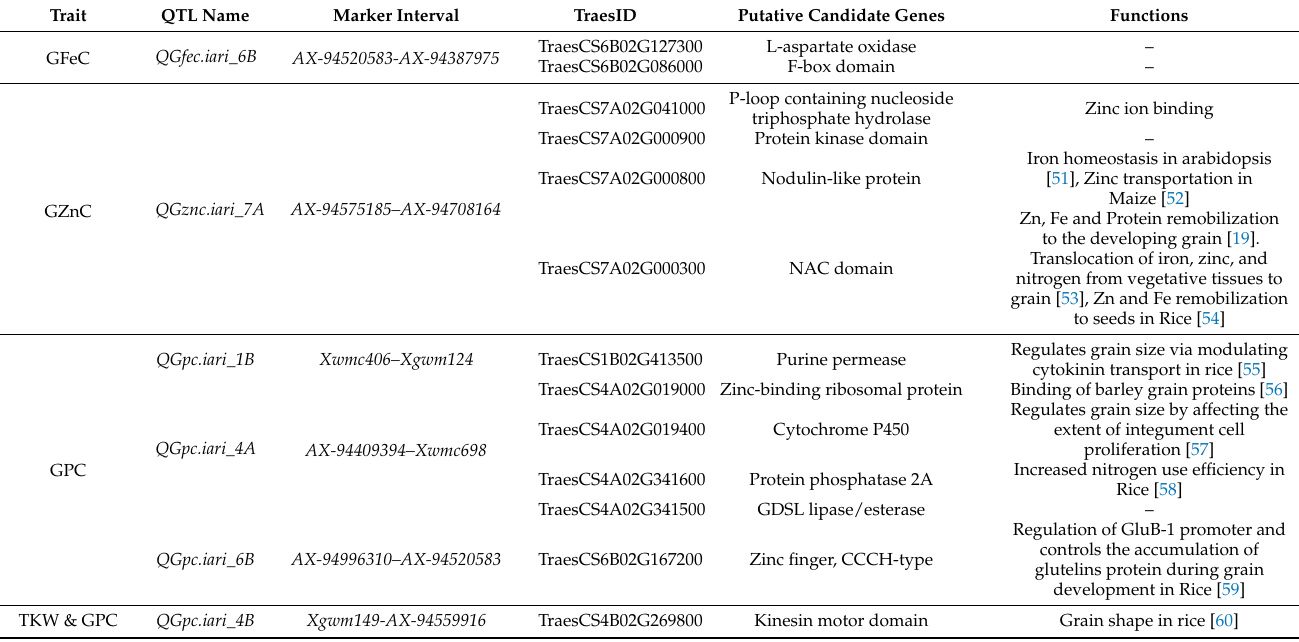
Table 3. List of putative candidate genes identified for GFeC, GZnC, GPC and